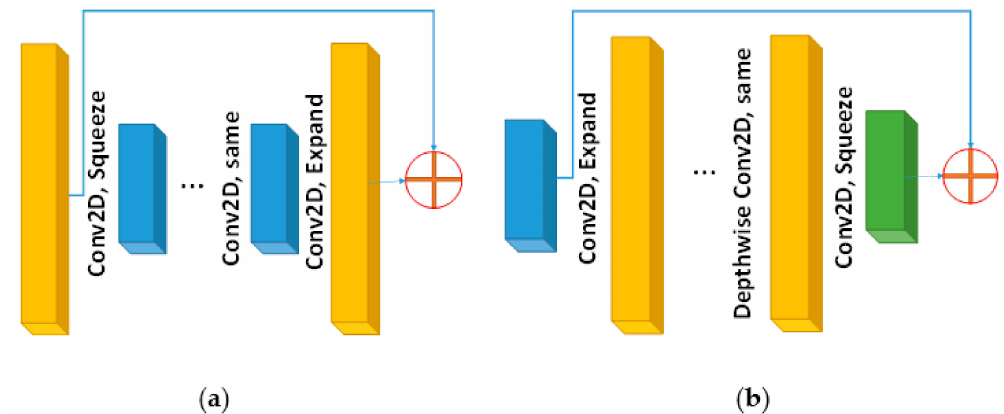
Figure 2. Illustration of the inverted residual block: ( a ) regular residual block where skip connection is between feature maps with a large number of channels, and ( b ) inverted regular residual block.